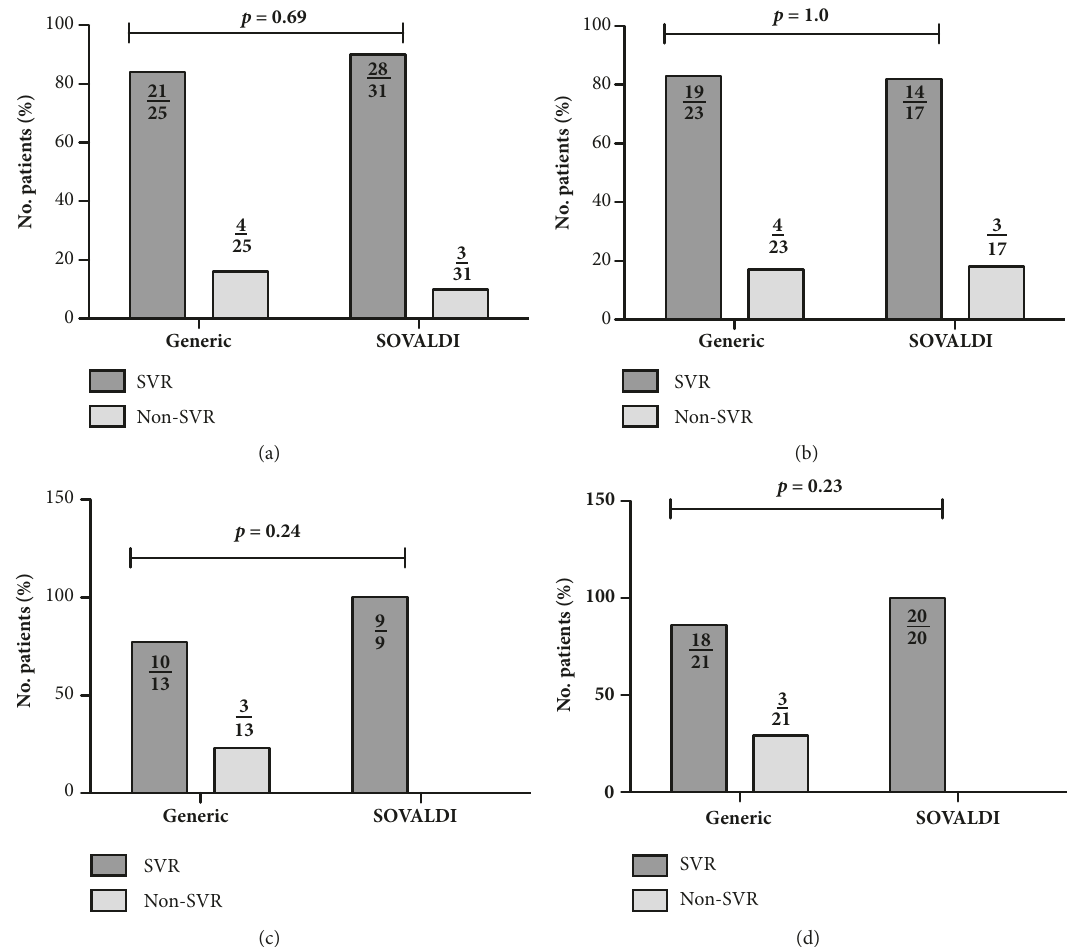
Figure 1: Virologic response among patients with available sustained virologic response (SVR). (a) Percentage of all patients. (b) Percentage of genotype 3 patients. (c) Percentage of all patients with compensated cirrhosis. (d) Percentage of all patients excluding decompensated